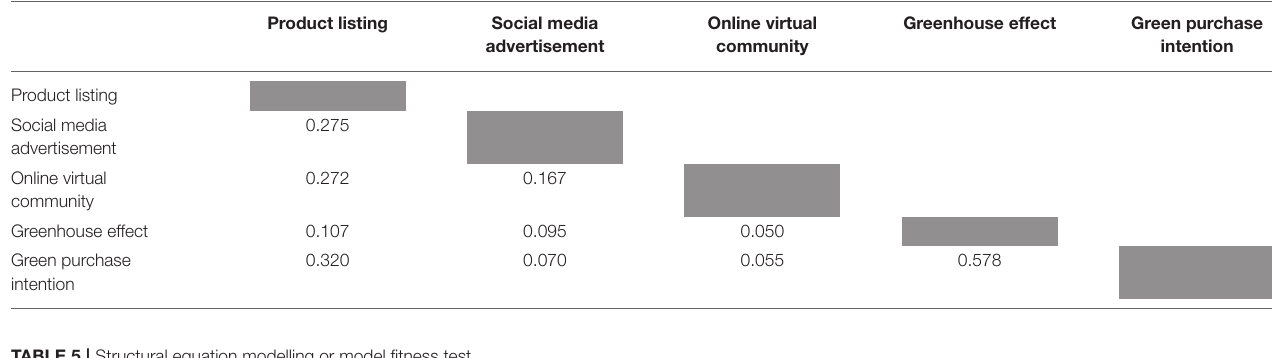
TABLE 5 | Structural equation modelling or model fitness test.